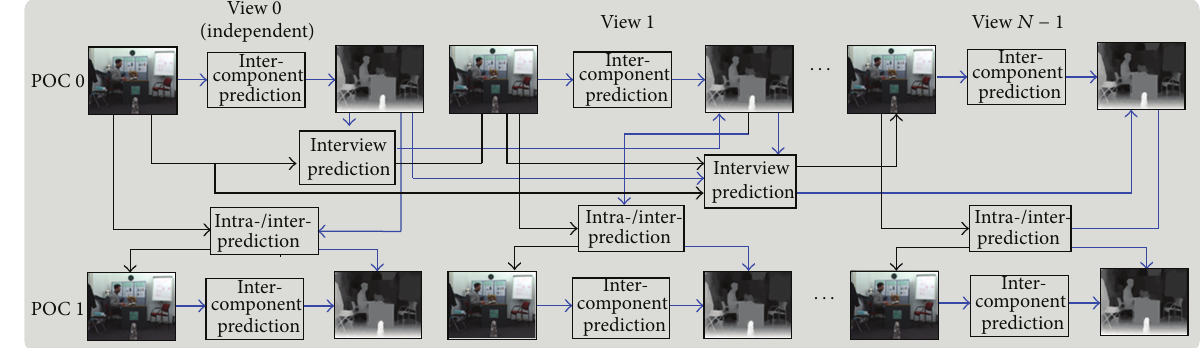
Figure 1: Basic encoder structure with interview and intercomponent